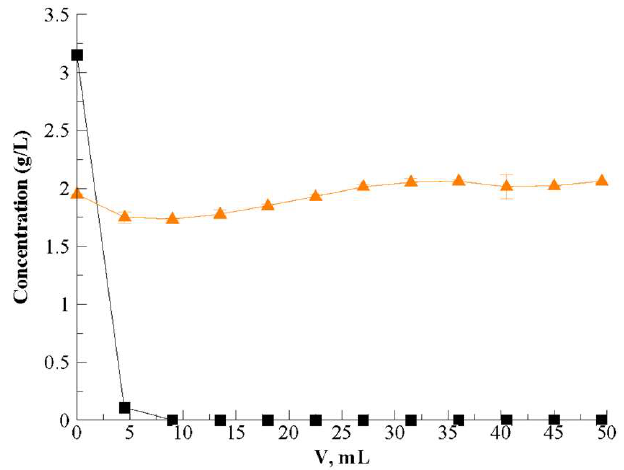
Figure 16. Concentration of ( ■ ) sinigrin and ( ▲ ) proteins in the juice during the dynamic adsorption at 5.3 BV/h and 30 °C.